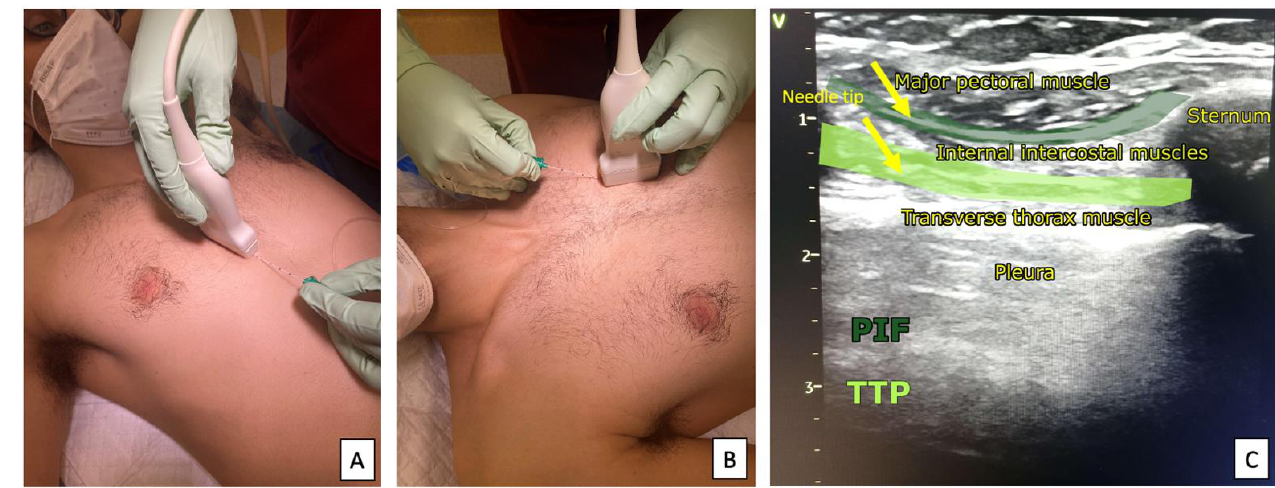
Figure 6. Ultrasound transducer positioning of the TTP ( A ) and PIF ( B ) blocks and sonoanatomy of the TTP and PIF blocks ( C ).